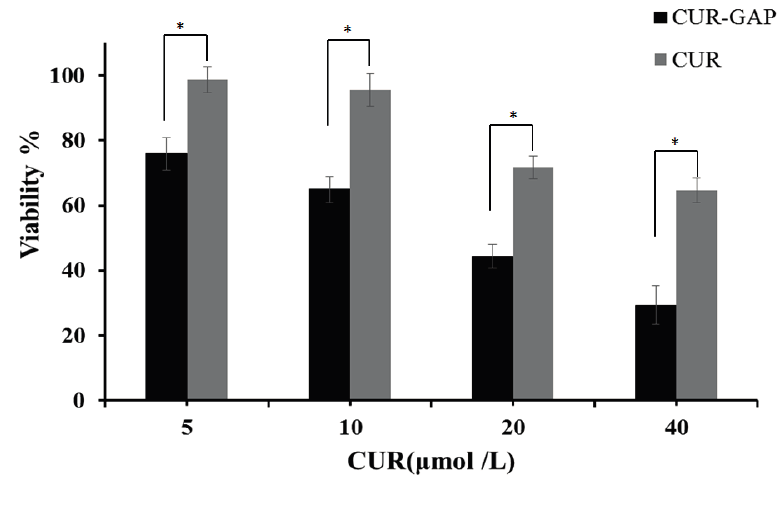
Figure 7. In vitro viability of CUR and CUR-GAP NPs in HepG2 cells at 24 h. Data are mean ± SD (n = 6), * p <